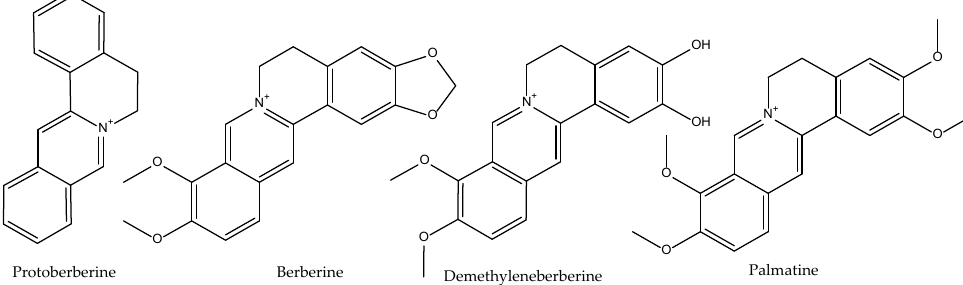
Figure 8. Bioactive anti-inflammatory (eicosanoid inhibition) and antioxidant principles from Coptis chinensis and Phellodendron amurense .